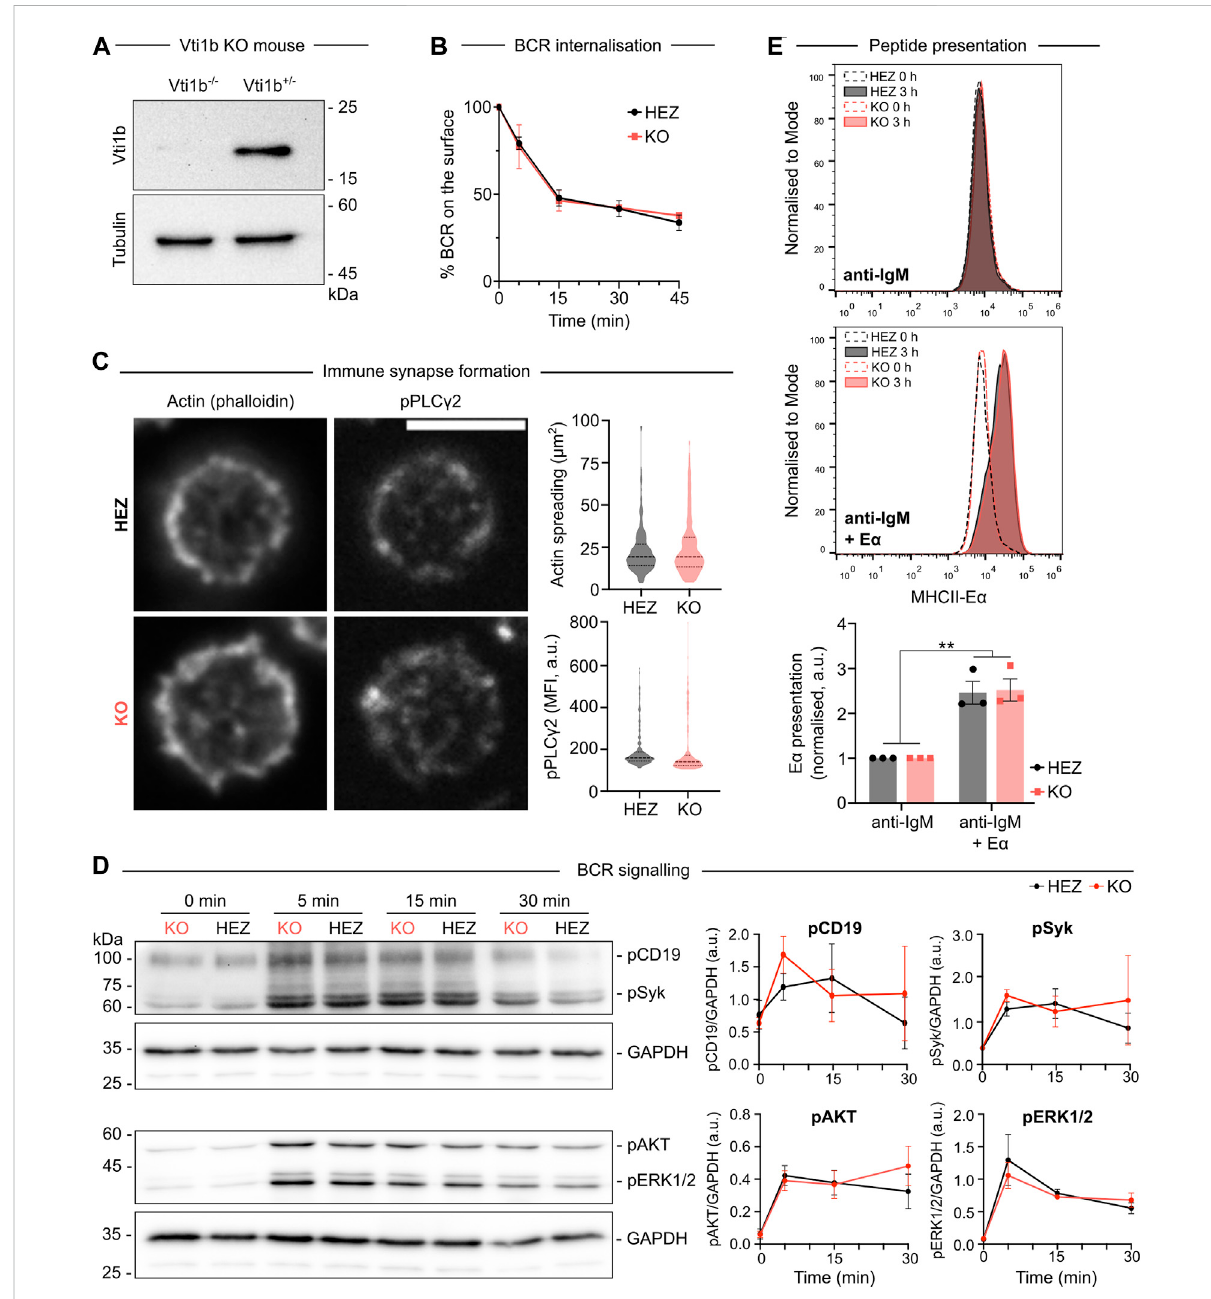
FIGURE 4 Vti1b-de fi ciencydoesnotaffectantigeninternalization,presentationorBCRsignalling. (A) WesternblotshowingtheexpressionofVti1binVti1b KO (Vti1b − / − ) or Vti1b HEZ (Vti1b +/- ) primary B cells isolated from the spleen. Tubulin was used as a loading control. (B) BCR internalisation rate upon antigen [anti-IgM F (ab ’ ) 2 ] activation was assessed by fl ow cytometry in HEZ and KO primary B cells. Results are presented as mean ± SEM ( n = 3 independent experiments). (C) The formation of the immune synapse. Primary B cells were isolated from the spleen and activated on antigen [anti-IgM F (ab ’ ) 2 ] coated glass for 15 min. Spreading was quanti fi ed based on the F-actin marked area (phalloidin) and signalling based on phospho- PLCg 2 intensity. Results as presented as violin plots ( n = 2 experiments). (D) Primary B cells were isolated from the spleen of HEZ or KO mice and activated with anti-IgM F (ab ’ ) 2 fragments for 5, 15, and 30 min. Early (pCD19, pSyk) and late (pAKT, pERK1/2) BCR signalling was analysed using immunoblotting.Resultsare presented as mean ± SEM( n = 3independentexperiments). (E) Primary Bcells wereactivated with anti-IgM or anti-IgM + E α peptide-coated beads and peptide presentation was analysed using antibodies speci fi c for MHCII-E α peptide complex in fl ow cytometry. Representative pro fi les (above) and quanti fi cation ( n = 3 independent experiments; below) are shown. Results are presented as mean ± SEM. p ** <